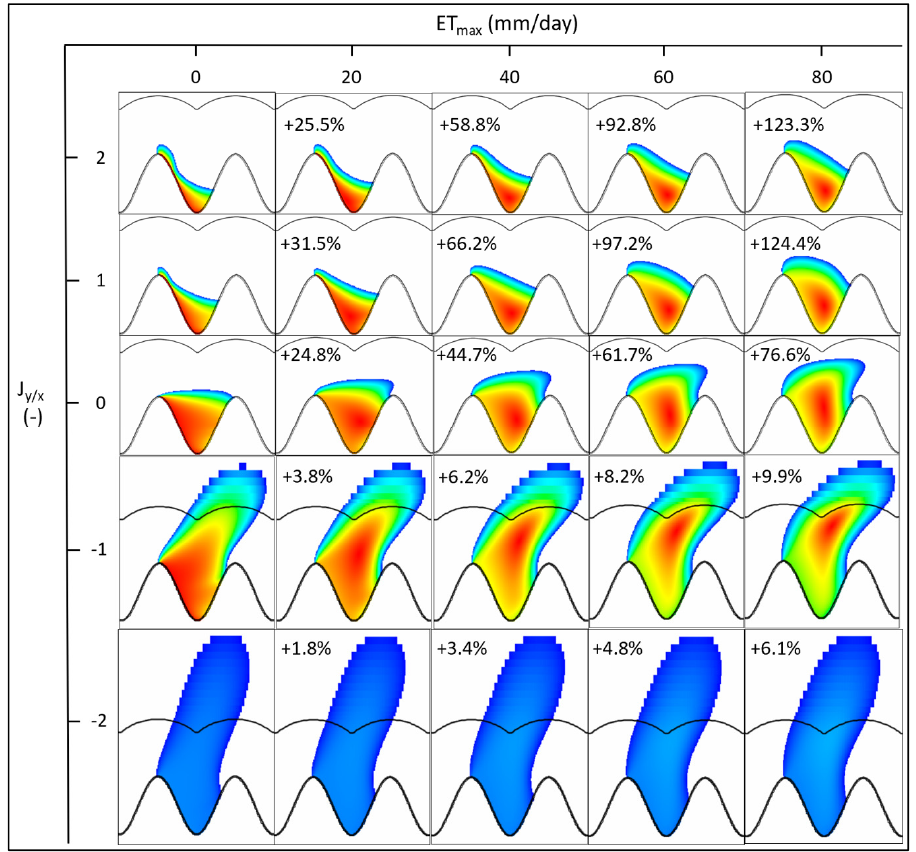
Figure 3. Maps of hyporheic zone area ( A HZ ) as a function of maximum daily ET ( ET max ) (columns) and regional groundwater flux ( J y/x ; positive for gaining, negative for losing) (rows). Each map is a snapshot taken at the 12th h of the last day of the simulation. The percentages listed are the percent increases in A HZ relative to the corresponding ET0 scenarios (left column). The colors on each map correspond to concentrations of stream water that have entered the aquifer; the range of concentrations are different for each simulation and so the colors cannot be compared between maps. The colors follow a rainbow gradient where blue indicates lower concentrations and red indicates higher concentrations.